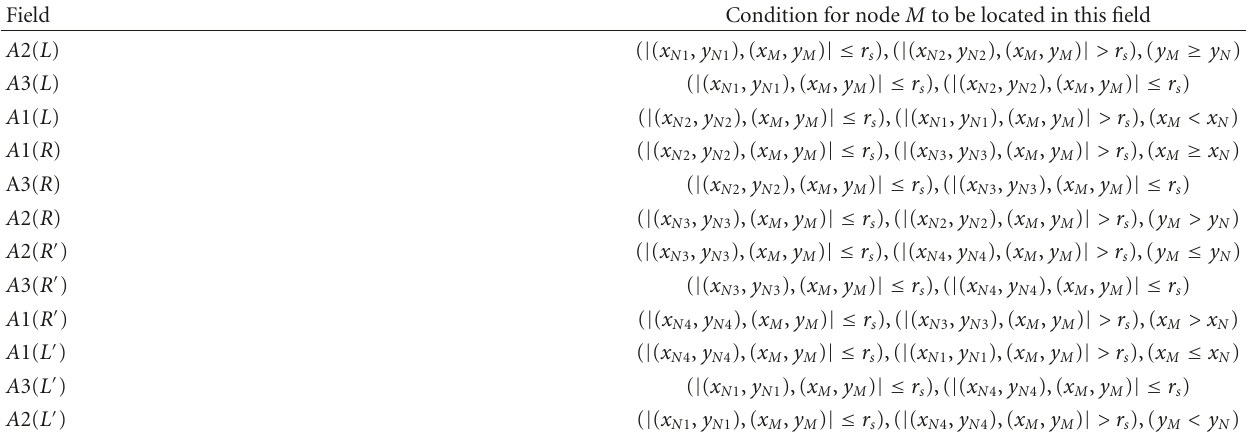
Table 2: The conditions for node M to be placed in a specific quadrant and field over node N ’s sensing region. Field Condition for node M to be located in this